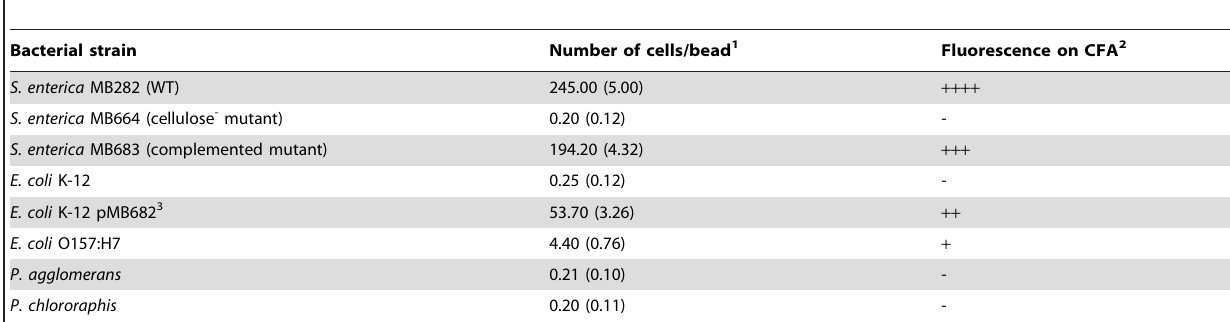
Table 1. Attachment of various bacterial strains to chitin beads, including S . Typhimurium wild-type and derivative strains affected in cellulose